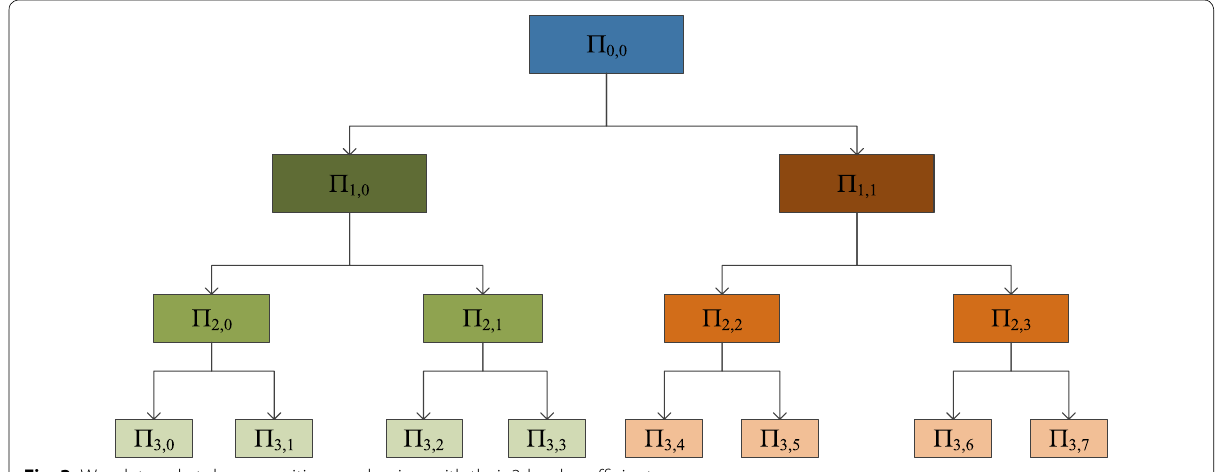
Fig. 3 Wavelet packet decomposition mechanism with their 3-level